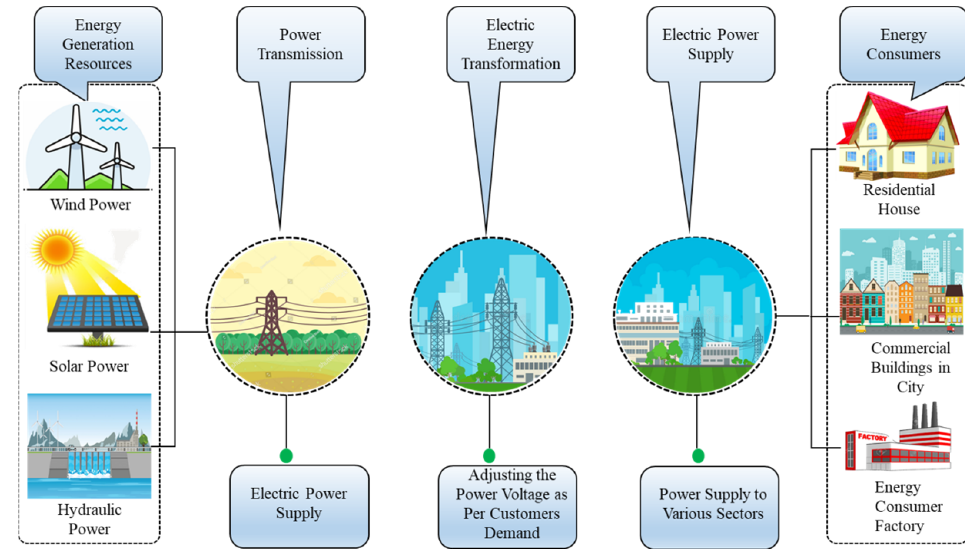
Figure 1. The overall mechanism of the energy generation, transformation, and consumption.